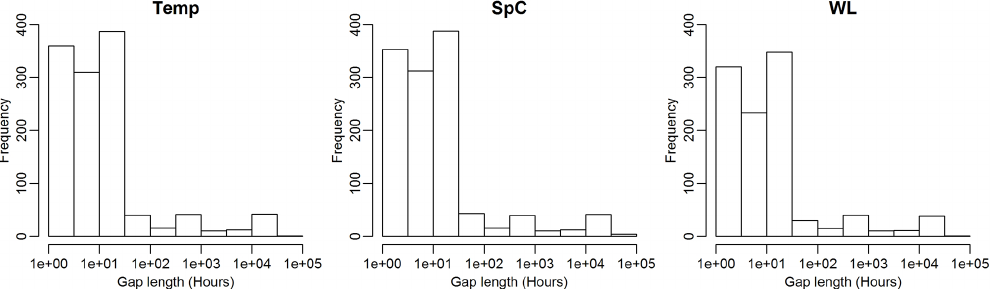
Figure 3. Histograms of gap lengths for each monitored variable, aggregated across all wells in the monitoring network from 2008 to 2018.